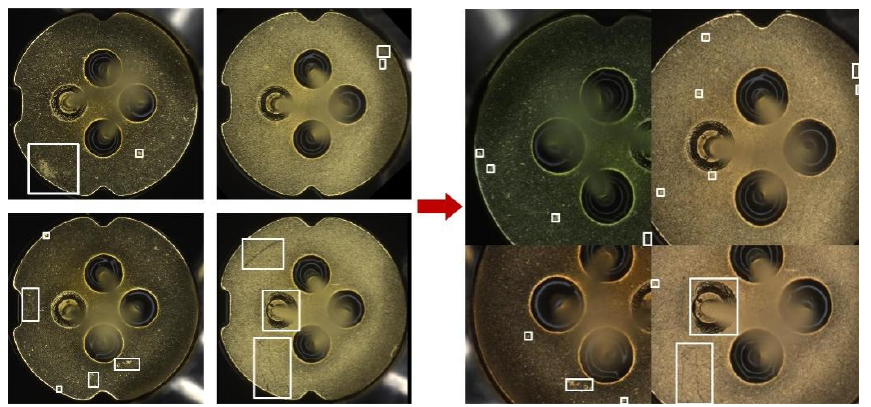
Figure 6. RPM data augmentation.